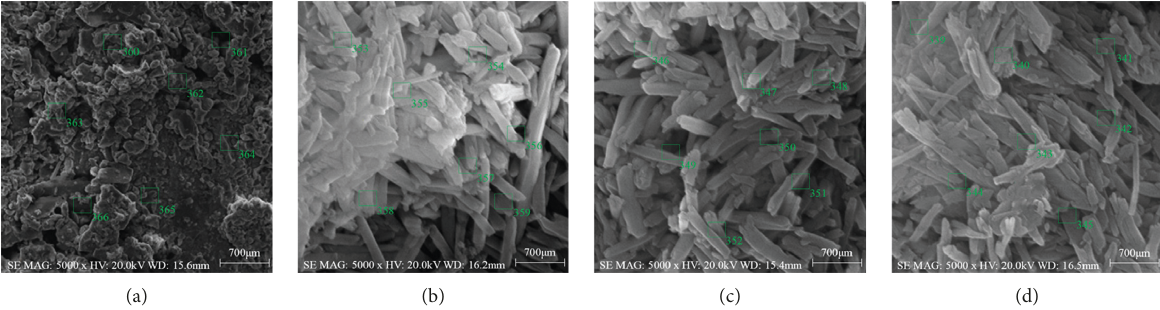
Figure 6: Layout of spectral scanning measurement points of the soil samples. (a) Original. (b) Spot A. (c) Spot B. (d) Spot C.